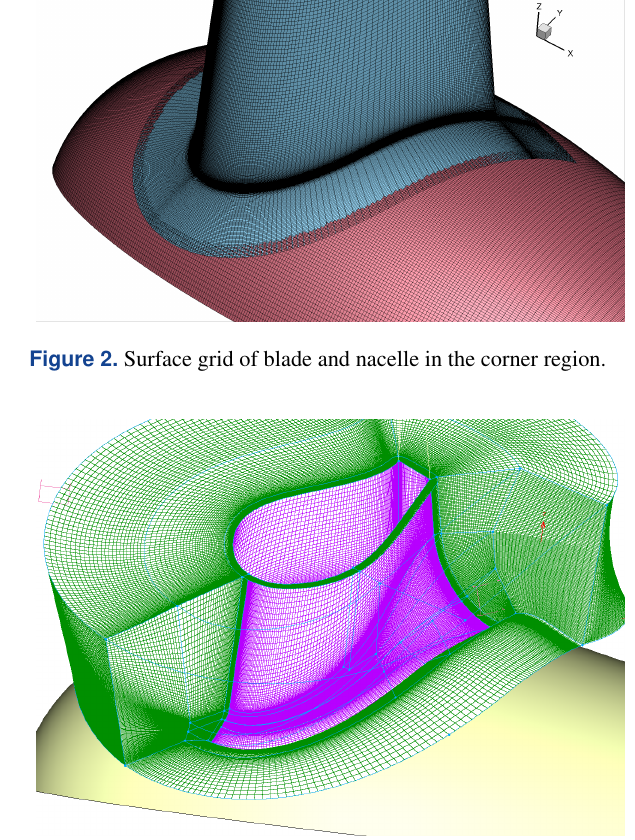
Figure 3. Grid topology for the fairing